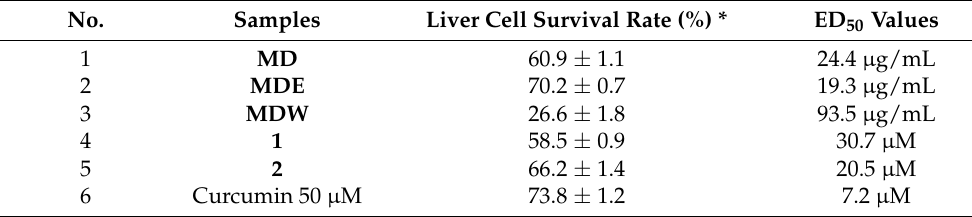
Table 4. Test results of in vitro antioxidant activity of crude extract, fractions, and compounds ( 1 and 2 ).